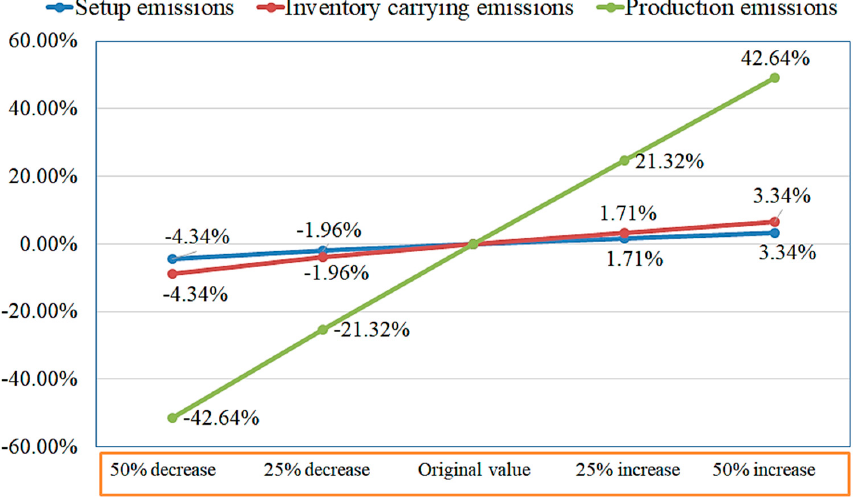
Figure 7. Sensitivity analysis of CO 2 emissions objective for the model with uncertain information.